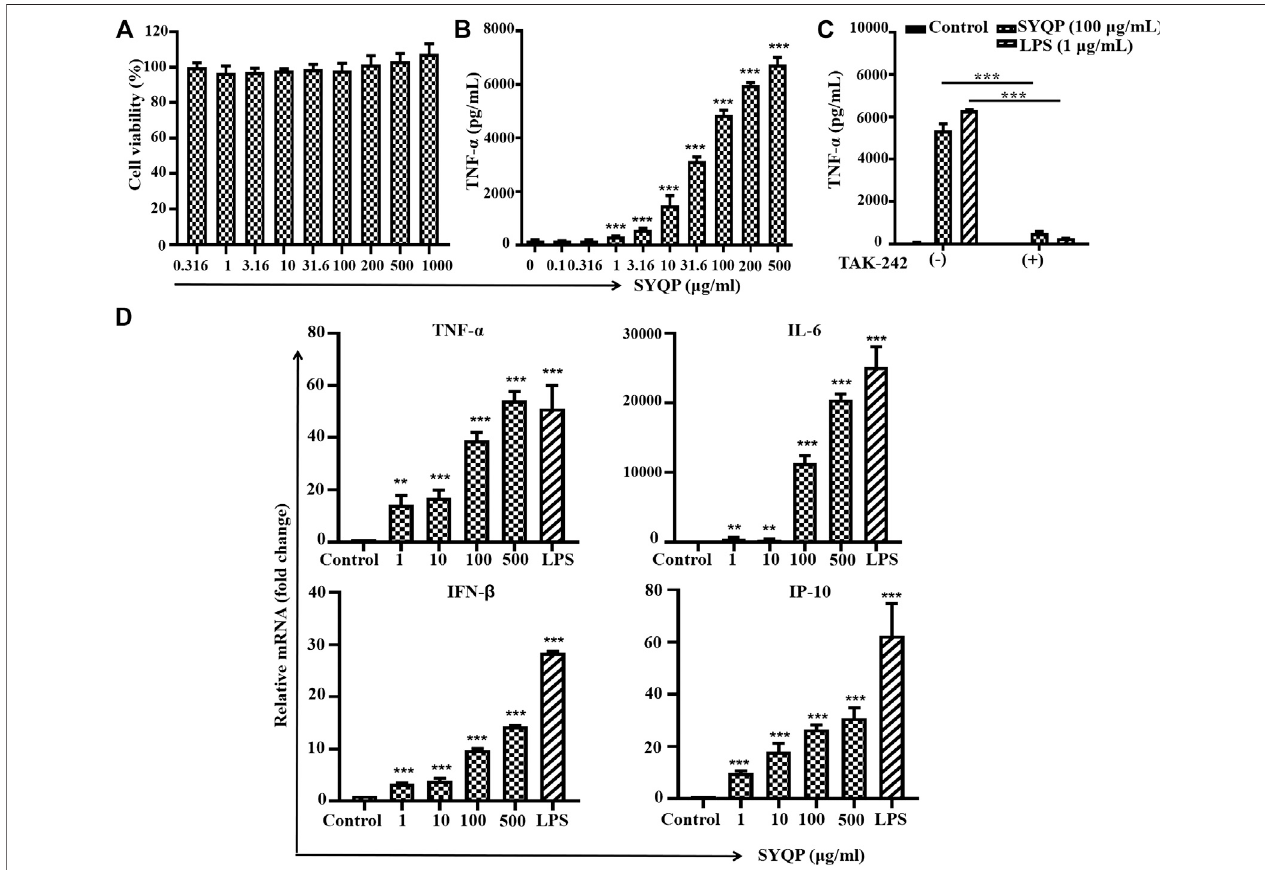
FIGURE 3 | SYQP stimulated mouse TLR4 in RAW264.7 cells. (A) Effects of SYQP on the viability of RAW264.7 cells. (B) SYQP increased the secretion of TNF- α from RAW264.7 cells. The cells weretreatedwith SYQP at the indicated concentrationfor 24 h. Cell culture mediumwas collected, and the secretion levels ofcytokines weredetectedbyELISA.*** p < 0.001vs.control. (C) TAK-242decreasedthesecretionofTNF- α promotedbySYQP.*** p < 0.001vs.cellstreatedwithandcellstreated without TAK-242. (D) SYQP upregulated mRNA expression of both MyD88- and TRIF-dependent cytokines in RAW264.7 cells. The cells were treated with 1, 10, 100,500 μ g/ml SYQPor1 μ g/mlLPSfor6 h. Afterthat,mRNAwasisolated,andthegeneexpression levelsofcytokinesweredetermined byreal-time PCR.** p < 0.01, *** p < 0.001 vs. control. All of the results are presented as the mean ± SD ( n (cid:2)